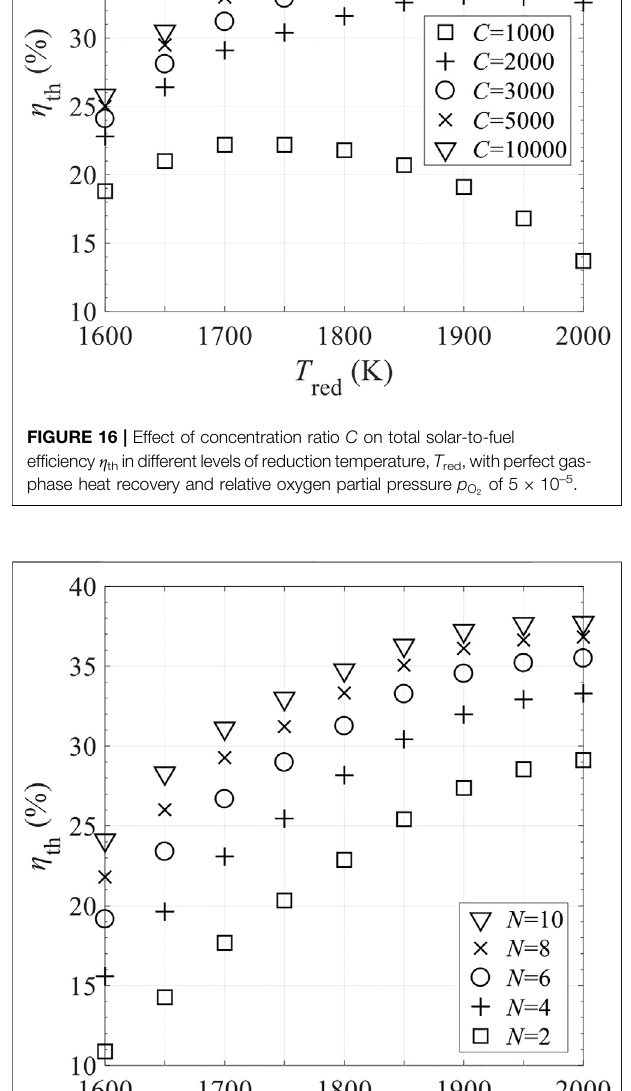
FIGURE 15 | Shifting frequency of secondary mirror, f , or reaction duration, τ , and total solar-to-fuel ef fi ciency, η th , as a function of mass of ceria in CRR, m RPC .